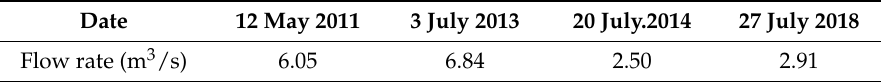
Table 1. Flow rates at the sampling site Trmice hydrological station